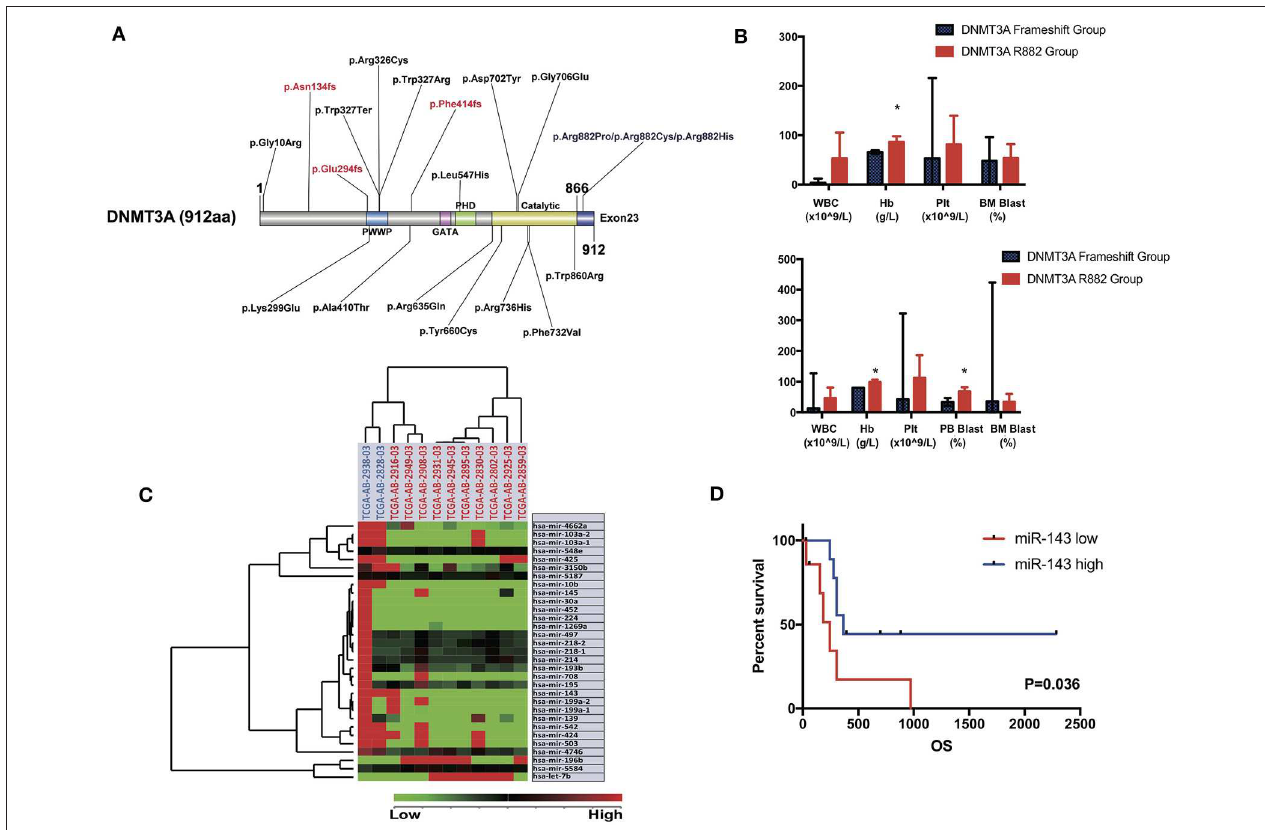
FIGURE 3 | (A) Schematic drawing of the DNMT3A protein structure and the detailed position distribution of each variant that was detected. Each conserved domain is labeled with different colors, and three DNMT3A frameshift mutations are marked with red letters. (B) Bar chart of mean value and standard deviation of the clinical characteristics (WBC, hemoglobin, platelet level of peripheral blood and blast percentage in bone marrow and peripheral blood sample) of AML patients carrying DNMT3A R882 and DNMT3A frameshift mutations from the patient cohort in our center (upper chart) and TCGA cohort (lower chart). Significant differences between the two groups were compared by an unpaired t -test (* P < 0.05). (C) Unsupervised hierarchical clustering analysis was performed on the significantly differentially expressed microRNAs in AML cases with DNMT3A R882 and DNMT3A frameshift mutations from the TCGA database. The cluster diagram of the miRNA expression values was mean-normalized. Samples with the DNMT3A R882 mutation are labeled with a red ID marker, while those with DNMT3A frameshift mutations are labeled with a blue ID marker. (D) Overall survival comparison of 2 groups of AML patients carrying DNMT3A mutations (R882s and non-R882s) from the TCGA database. Patients were separated into high/low group by the expression value ranking of miR-143. Each group contained nine patients, whose expression value ranked top or bottom 45%. Survival analysis was performed with the Kaplan-Meier method and was statistically compared with the Gehan-Breslow-Wilcoxon